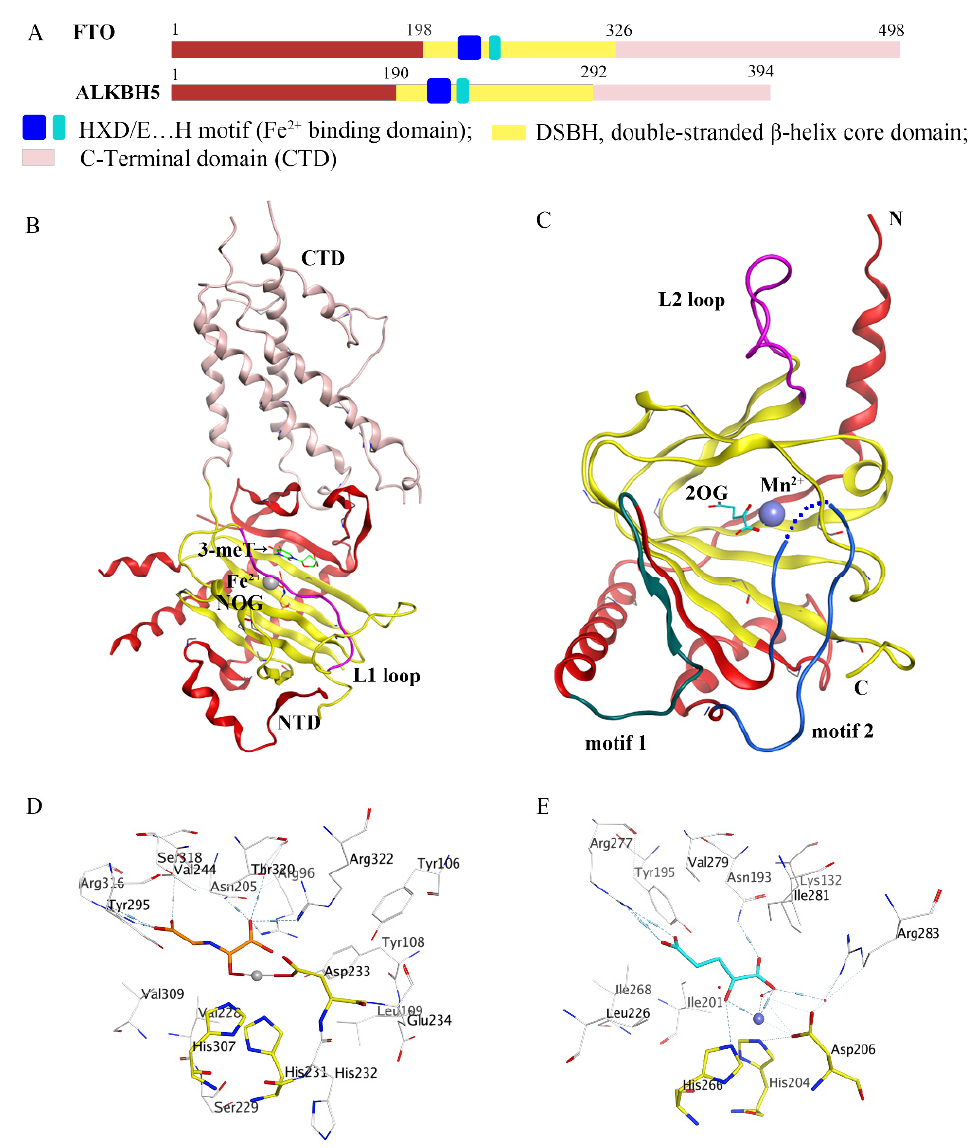
Figure 2. Comparison of fat-mass- and obesity-associated protein (FTO) and alkB homolog 5 (ALKBH5). ( A ) Structural domain representation of FTO and ALKBH5. ( B ) Crystal structure of FTO ∆ 31-3-meT (PDB ID: 3LFM) generated by MOE software. C-terminal domain (CTD) is colored in pink; N-terminal domain (NTD) is colored in red; the L1 loop is colored in purple; 3-meT is colored in green; N-oxalylglycine (NOG) is colored in orange; Fe 2+ is colored in grey. ( C ) Crystal structure of ALKBH5 66-292 -2OG (PDB ID: 4NRO) generated by MOE software; the motif 1 region is colored in dark green; the motif 2 region is colored in dark green; the L2 loop is colored in purple; 2-oxoglutarate (2OG) is colored in cyan, Mn 2+ is colored in light blue; N: N-terminus, C: C-terminus. ( D,E ) The detailed interactions of the active center of FTO (PDB ID: 3LFM) and ALKBH5 (PDB ID: 4NRO) generated by MOE software. NOG and 2OG are colored in orange and cyan, respectively; Fe 2+ and Mn 2+ are drawn as grey and blue balls, respectively.